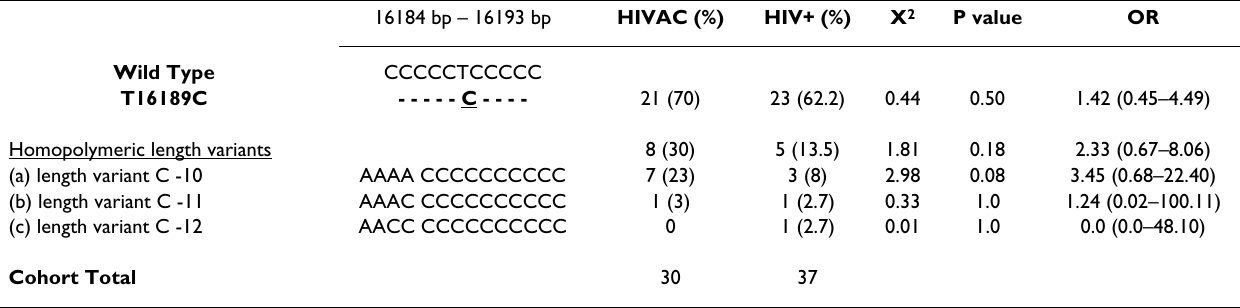
Table 2: Frequency of other polymorphisms in the 10 bp D-loop region (16184 bp–16193 bp) in cases and